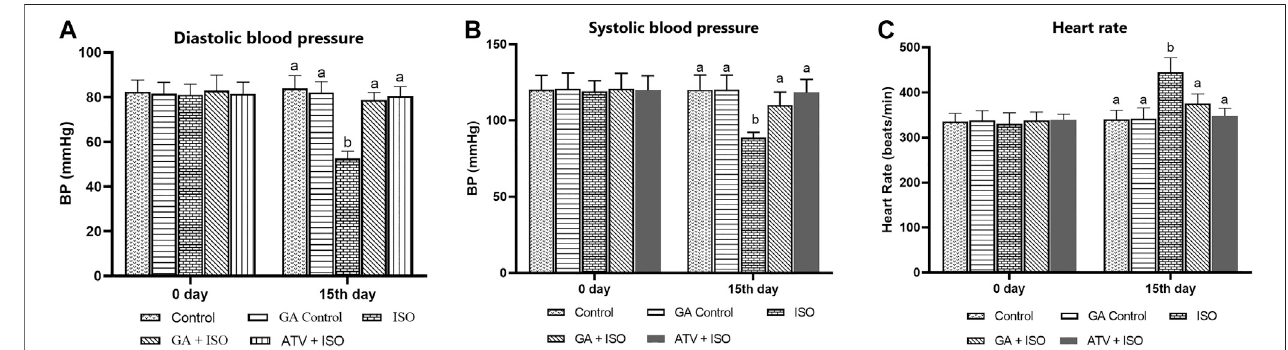
FIGURE2| EffectofGAonbloodpressureandheartrateincontrolandISO-induced rats. (A) EffectofGAondiastolicbloodpressuremeasurementincontroland ISO-induced in rats (B) Effect of GA on systolic blood pressure measurement in control and ISO-induced in rats. (C) Effect of GA on heart rate measurement in control